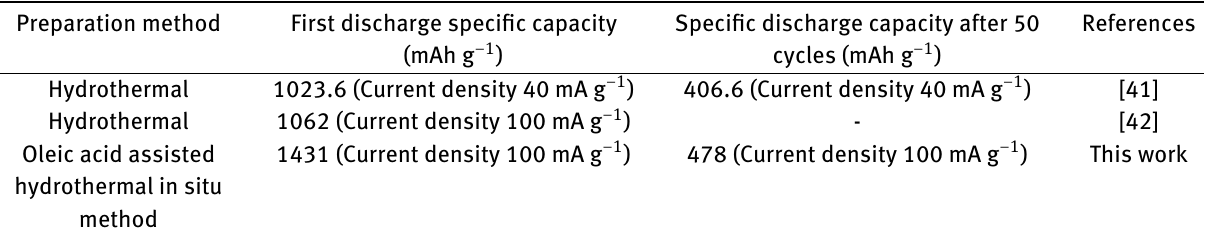
Table 2: Fe 2 O 3 /graphene material specific capacity Preparation